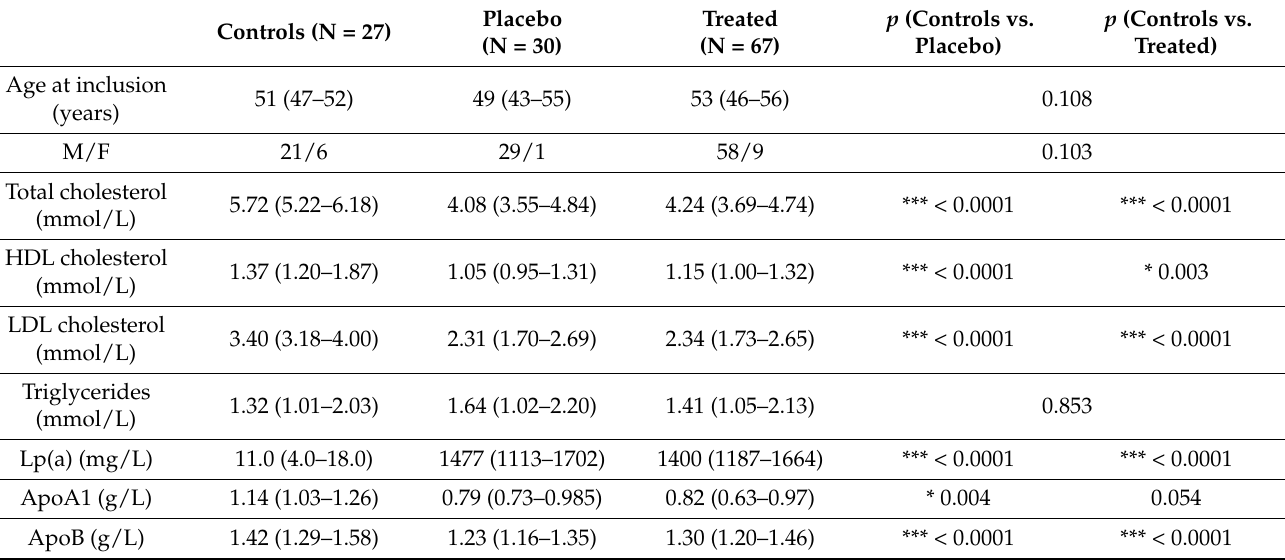
Table 1. Baseline characteristics of the three study